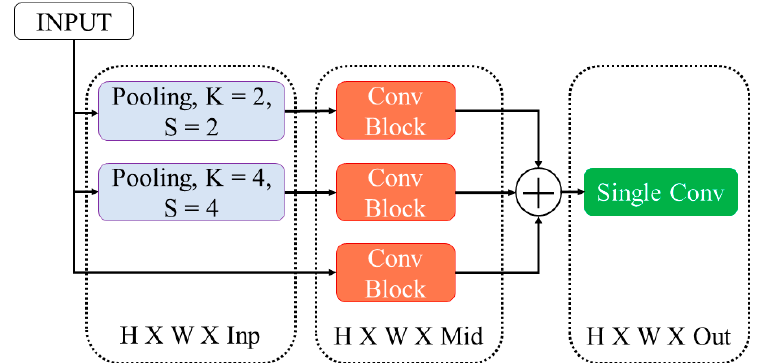
Figure 3. Architecture of the pooling convolution layer which consists of several pooling operations with various sizes and strides.